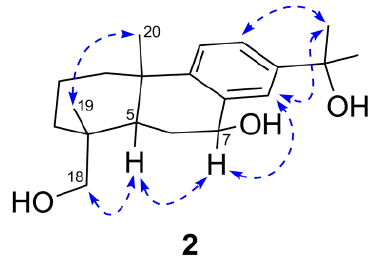
Figure 3. Key NOESY ( ) correlations of compound 2